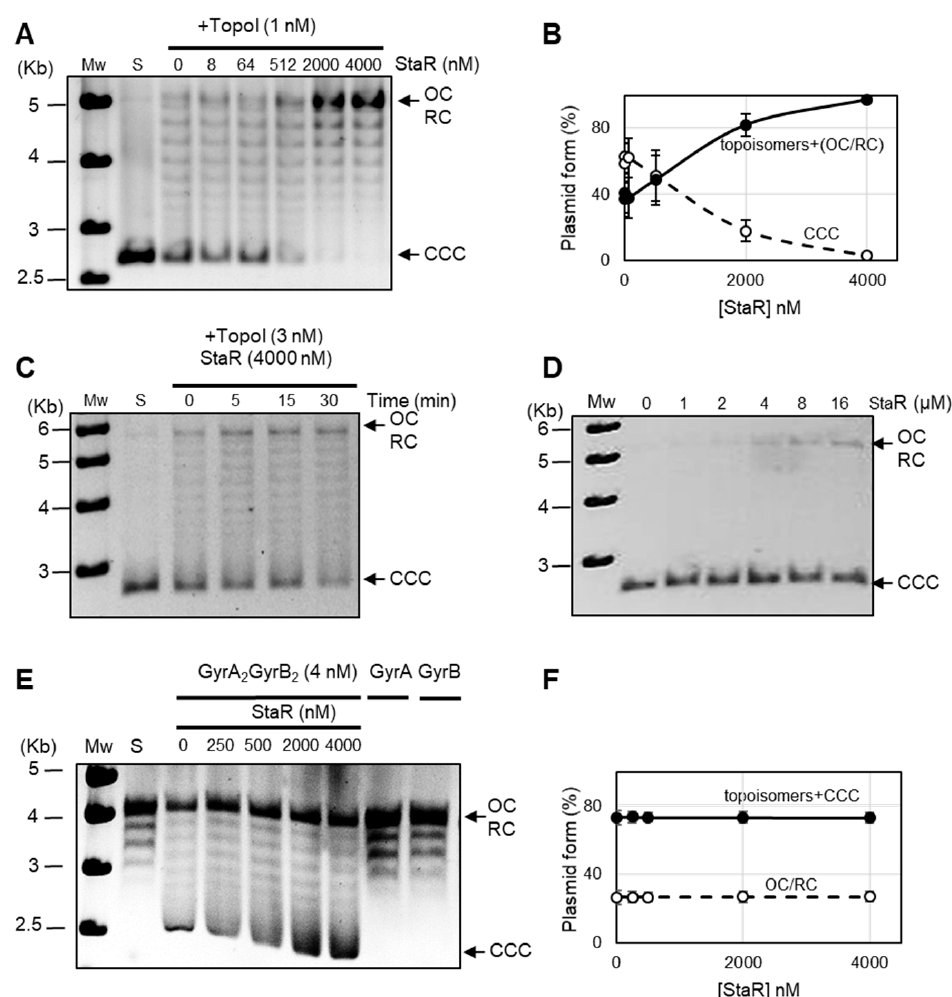
Figure 6. StaR activates the relaxation activity of S. pneumoniae TopoI but does not have any effect on gyrase. ( A ) Activation of TopoI as a function of StaR concentration. Plasmid pBR322 was incubated at 37 ◦ C with purified TopoI for 1 h. The indicated StaR concentrations were added simultaneously to the reaction mix. Samples were processed and analyzed as described in the Materials and Methods section. Mw, molecular weight standard (Kb); S, substrate; CCC, covalently closed circles; OC, relaxed open circles; RC, relaxed circular plasmid forms. ( B ) Activity of TopoI determined as increase of the topoisomers (including OC/RC forms) and decrease of CCC form in the presence of StaR. Results are the average ± SEM of three independent replicates. ( C ) Activation as a function of reaction time. Reactions were carried out as in ( A ). ( D ) StaR does not have topoisomerase activity by itself. Reactions were carried out as in A, except that TopoI was not added. Concentrations of StaR are indicated. ( E ) DNA gyrase activity is not affected by StaR. Supercoiling activity over relaxed pBR322 using 4 nM of reconstituted gyrase was assayed in the presence of different StaR concentrations at 37 ◦ C for 1 h. Incubation with GyrA or GyrB alone is included as a control. ( F ) Activity of gyrase determined as percentage of topoisomers +CCC and percentage of OC/RC forms in the presence of StaR. Results are the average ± SEM of three independent